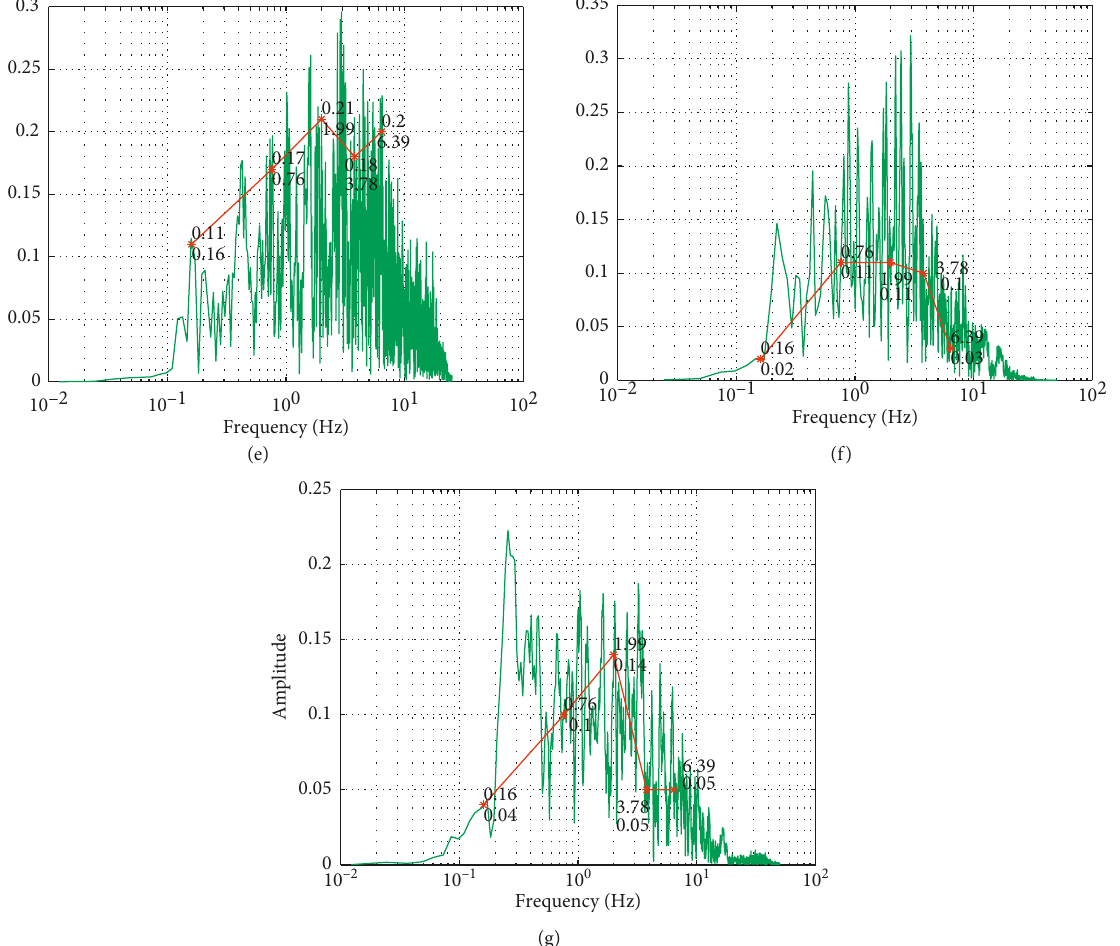
Figure 19: Fourier transform ofearthquakeexcitations. (a)Bam.(b)El Centro. (c)Kobe.(d)Landers.(e)Manjil.(f)Northridge.